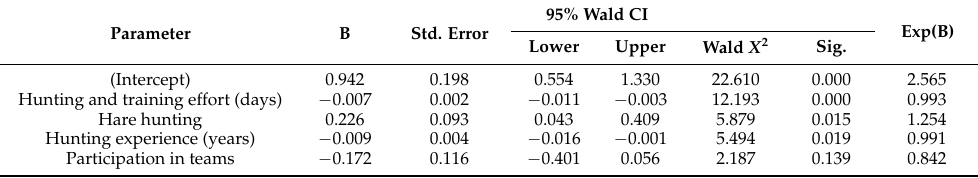
Table 3. Factors affecting levels of mean annual rates of hunting dog depredations per affected hunter (GLM with linear link function: X 2 likelihood ratio test = 17.848, p = 0.001, AICc = 11.912 for the “verified-probable” data